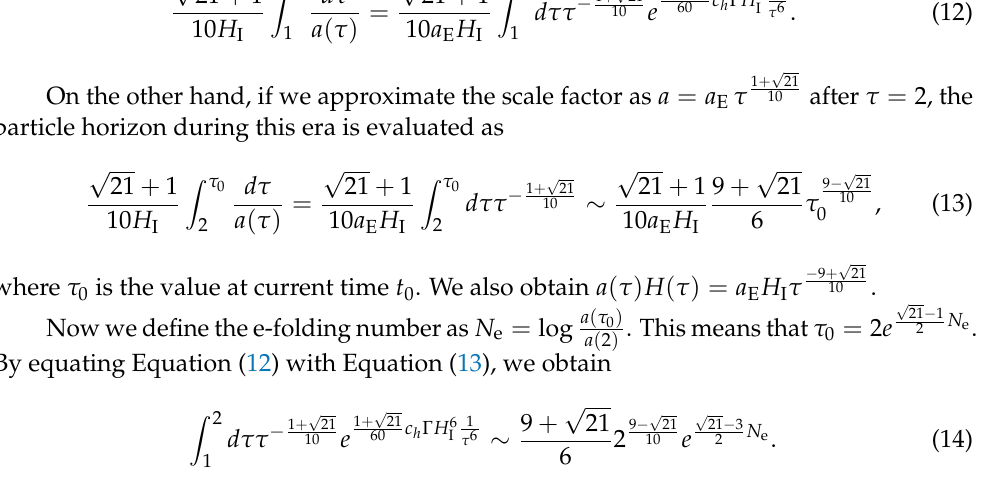
√ 21 1 c h Γ H 6 (orange) and 1 + 60 I τ 6 = c h Γ H 6 h I